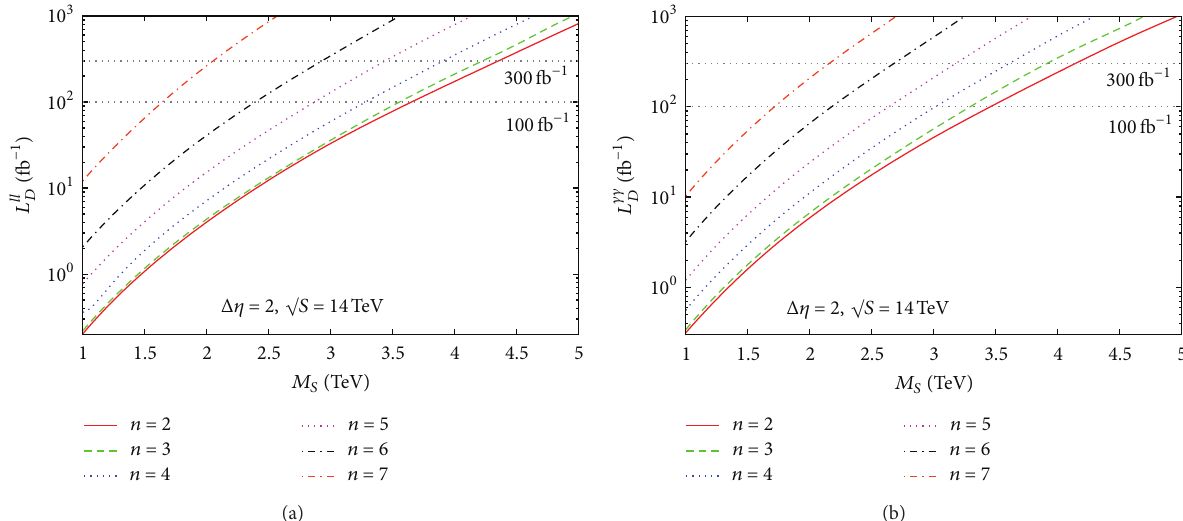
Figure 13: The required luminosity ( 𝐿 𝐷 ) for the discovery of KK graviton in (a) dilepton and (b) diphoton channels as a function of 𝑀 𝑆 at the 14TeV LHC with “discovery cuts” (see text for the definitions of the cuts). The 𝐿 𝑙𝑙 𝐷 and 𝐿 𝑝𝑝 → 𝑋 + 𝜓𝜓 + 𝑌 level where 𝜓 = {𝑙,𝛾} .